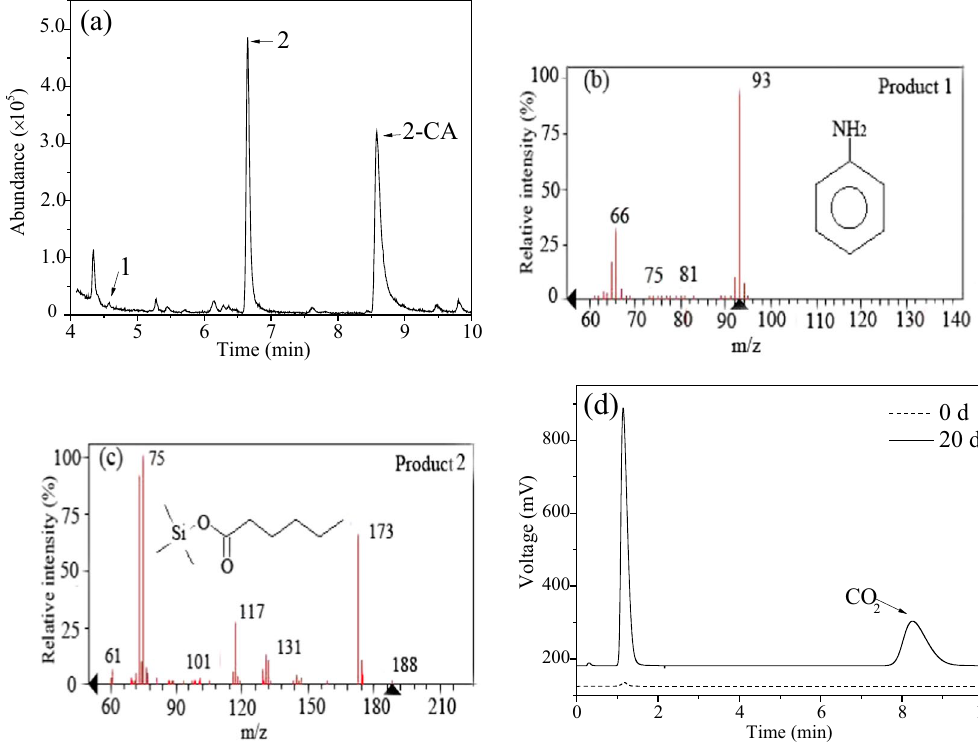
Figure 4. GC-MS chromatogram of the degradation products of 2-CA and GC chromatogram of CO 2 from hexanoic acid degradation. ( a ) Total ion chromatogram; ( b ) Mass spectrum of aniline; ( c ) Mass spectrum of hexanoic acid; ( d ) GC chromatogram of CO 2 .